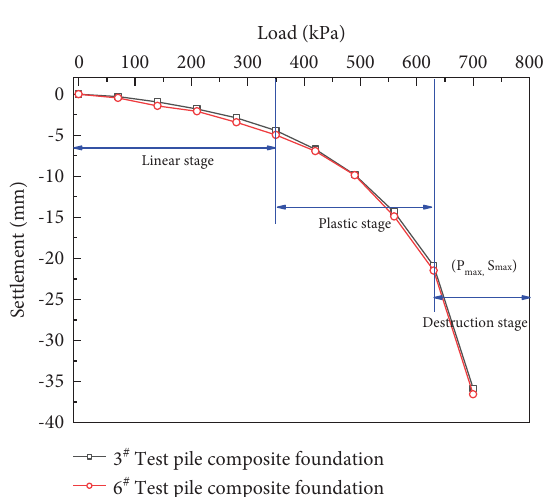
Figure 10: Test pile composite foundation load-settlement curves of single piles No. 3 and